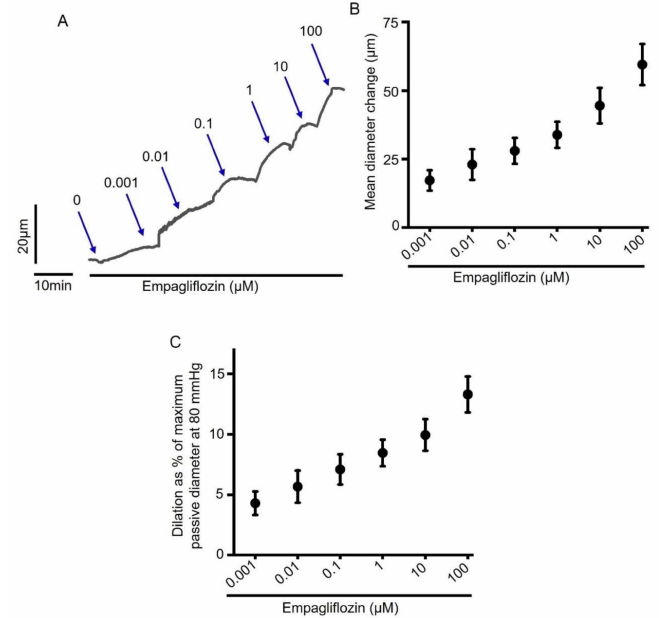
Figure 1. Empagliflozin stimulates concentration-dependent vasodilation in myogenic resistance- size mesenteric arteries. ( A ) An original trace illustrating vasodilation in a rat mesenteric artery at different concentrations (0.001 to 100 µ M) of empagliflozin. ( B ) Mean data for empagliflozin- induced vasodilation, n = 6. ( C ) Mean data for empagliflozin-induced vasodilation expressed as % of maximum passive diameter at 80 mmHg, n = 6.